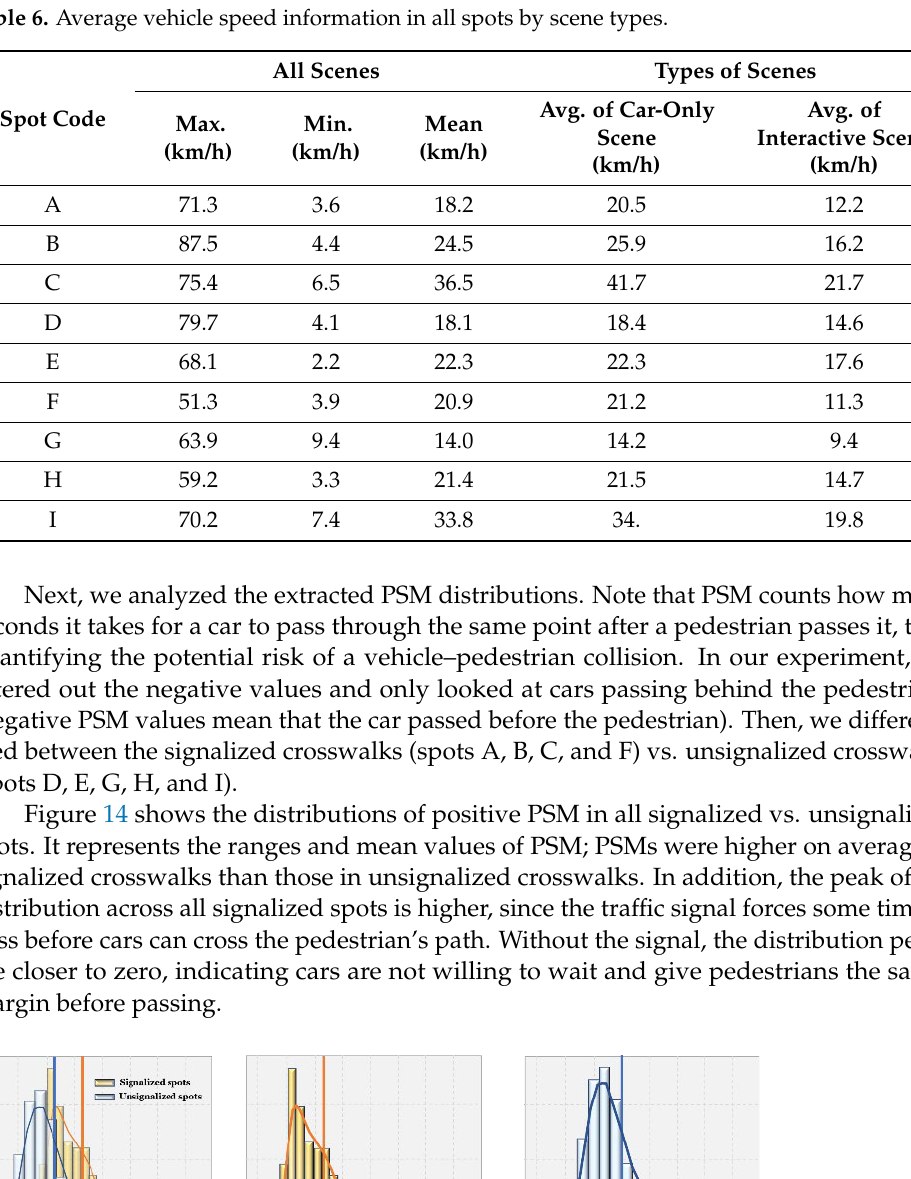
Table 6. Average vehicle speed information in all spots by scene types.